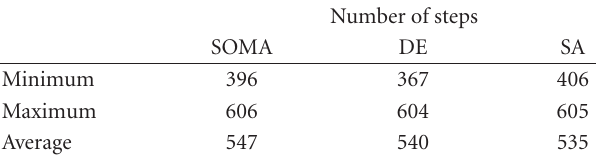
Table 6: Number of steps.